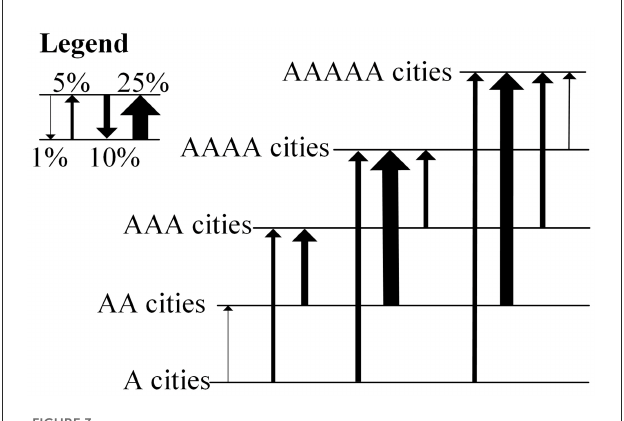
FIGURE3 The net migration flows up the city hierarchy. The arrow of the line indicates the direction of net migration, and the width of line indicates the percentage of total net migration between all levels of the hierarchy.